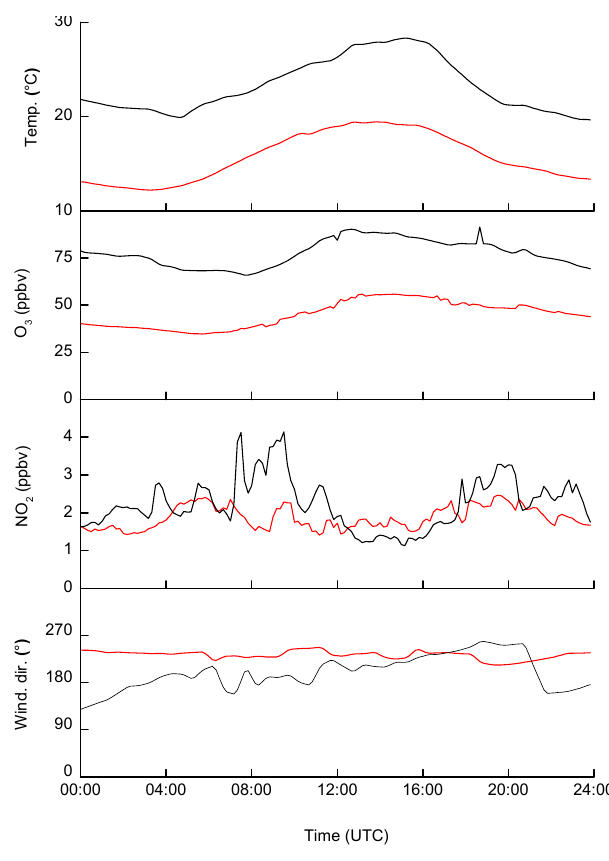
Figure 5. Mean daily profiles of O 3 , temperature, NO 2 , and wind direction for the NOTOMO campaign separated into days with a clear influence from local rush hour traffic (black). The rest are shown in red.